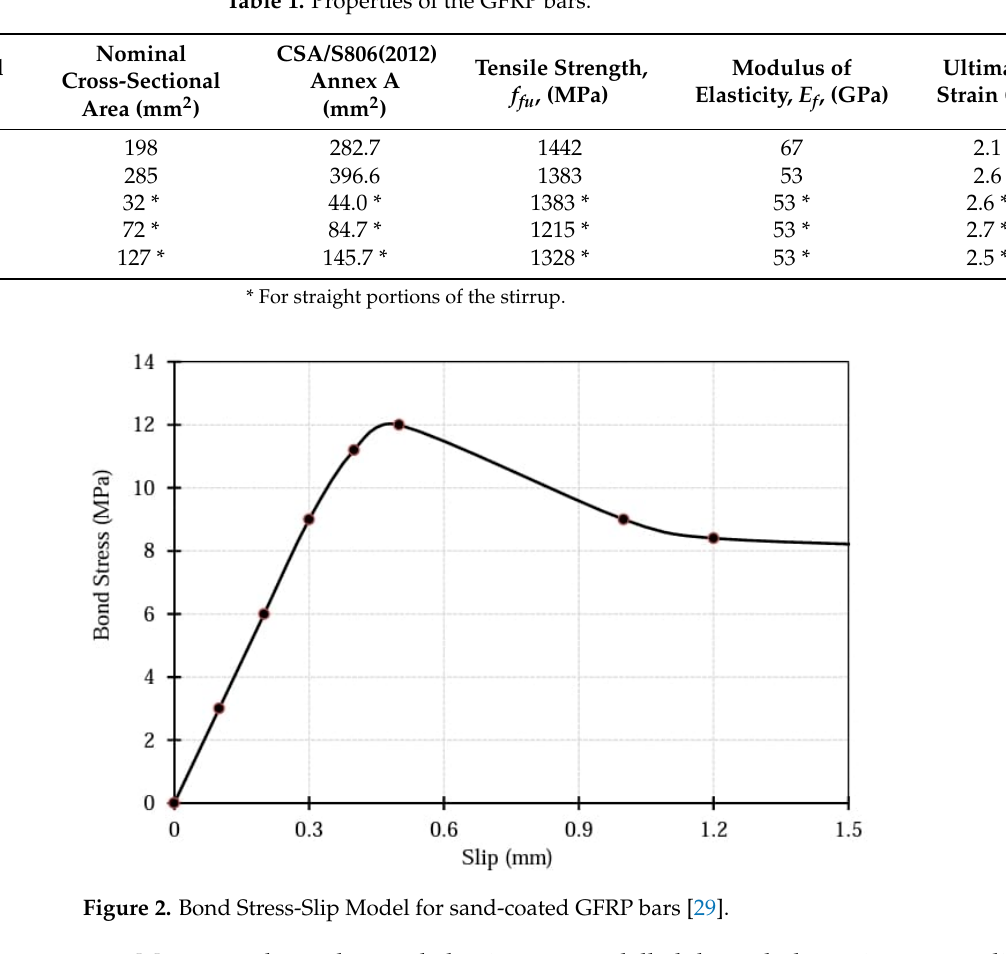
Table 1. Properties of the GFRP bars.